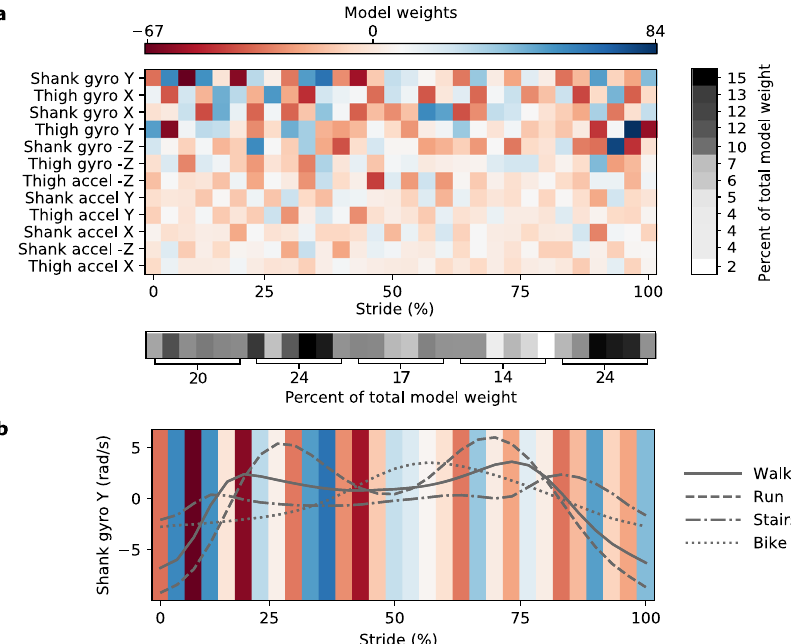
Fig. 4 Interpreting the Wearable System. a The Wearable System used a linear regression model to estimate energy expenditure with inputs from inertial measurement units worn on the shank and thigh. The inertial measurement units consist of a three-axis accelerometer (accel) and a three-axis gyroscope (gyro). The X , Y , and Z directions represent the fore-aft, mediolateral, and vertical axes, respectively. These orientations are assigned during quiet standing, but the sensors are attached to different body parts that move relative to the global reference frame. Input data were low-pass fi ltered, split by stride, and discretized each stride to a fi xed input size before being used in the model. The model used ridge regularization that penalized the sum of the squared model weights. A larger magnitude weight indicated a more informative input. The input signals are shown in descending order of importance based on contribution to total model weight. Gyroscope inputs were more informative than accelerations. Inputs in the second and fi fth quintile of each stride were the most informative. b The input signal with the largest weight, the gyroscope measurement of the shank in the sagittal plane, was plotted for each activity alongside the model weights. The linear regression model may relate the absolute value of signals to energy expenditure or differentiate two points of the input data to approximate a derivative. Interpretation is challenging as all inputs are compared at